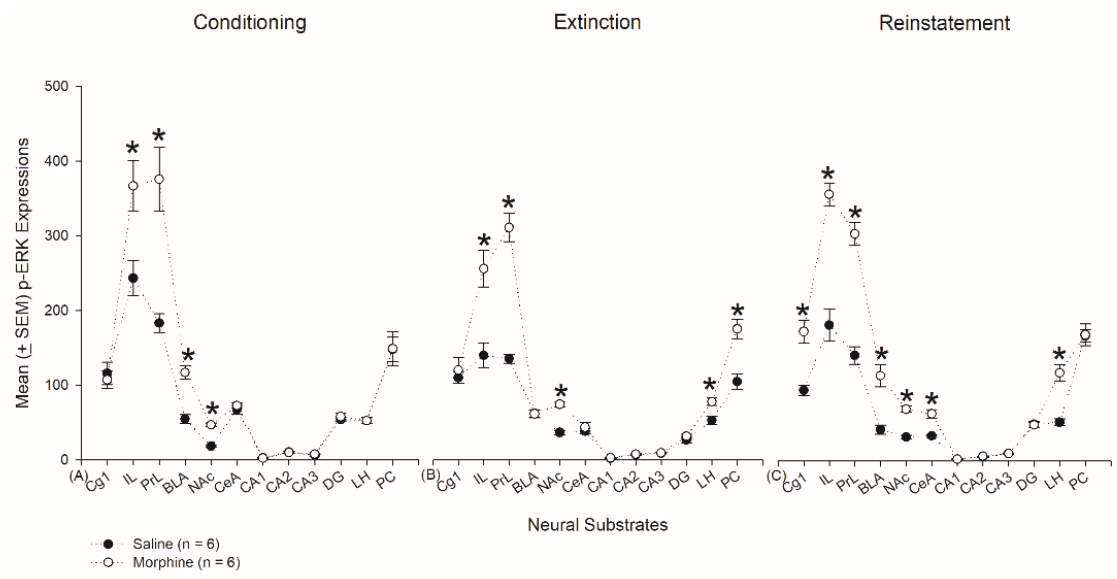
Figure 19. Assessing homeostasis analysis using the p-ERK expression for the cingulate cortex area 1 (Cg1), the prelimbic cortex (PrL), the infralimbic cortex (IL), the basolateral amygdala (BLA), the nucleus accumbens (NAc), the central amygdala (CeA), the CA1, the CA2, the CA3, the dentate gyrus (DG), the lateral hypothalamus (LH), and the piriform cortex (PC) in the three phases: ( A ) conditioning, ( B ) extinction, and ( C ) reinstatement. * p < 0.05 when comparing the saline and morphine groups ( n = 6 per group). Table 2. Indicating the total of brain regions (12). Numbers and percentages of neural substrates for c-Fos or p-ERK hyperexpression on conditioning, extinction, and reinstatement phases after morphine-induced conditioned suppression of saccharin solution intake.